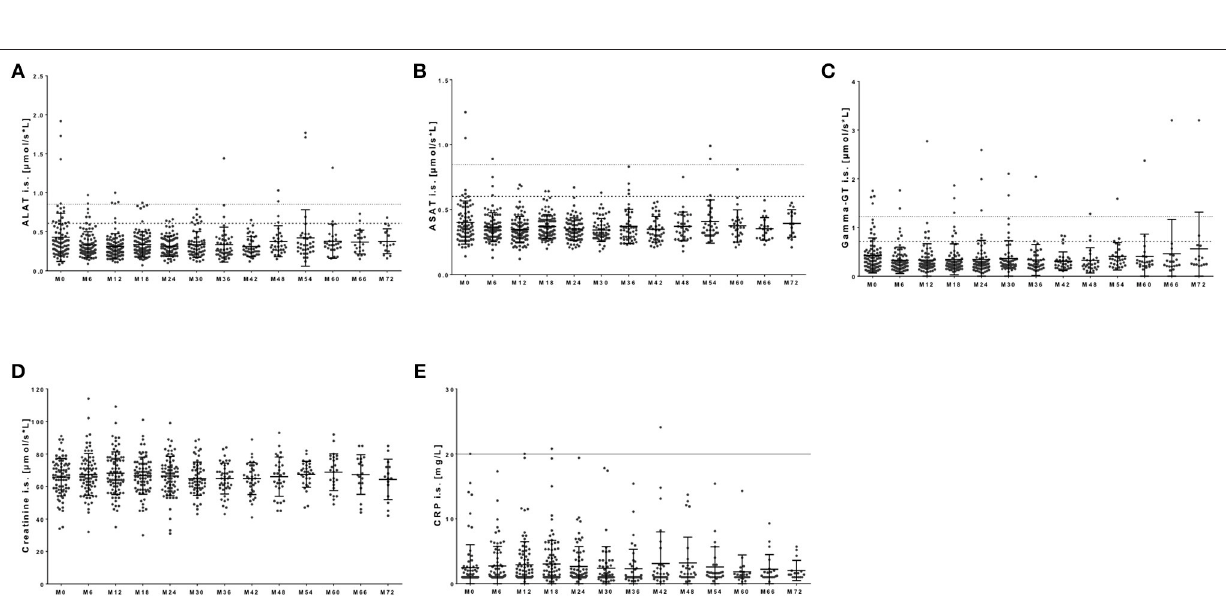
Frontiers in Neurology | www.frontiersin.org